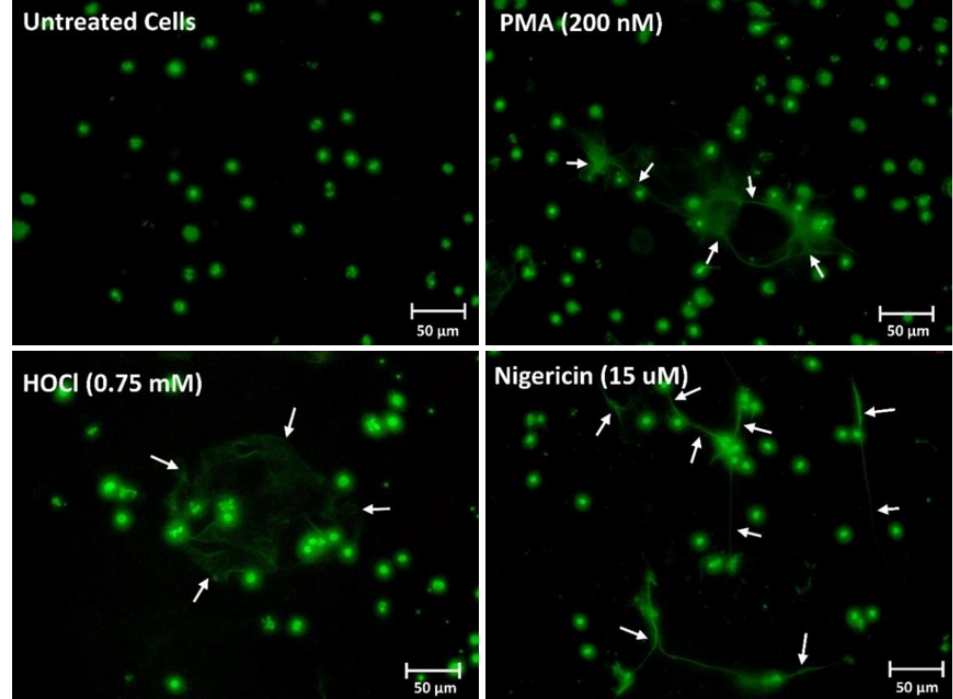
Figure 2. PMA, HOCl and nigericin induce NET release in differentiated PLB-985 cells. Differentiated PLB-985 cells (4 × 10 5 cells) were treated with PMA (200 nM), HOCl (0.75 mM) or nigericin (15 µ M) for 4 h at 37 ◦ C. After the treatment, the cells were fixed in 4% formaldehyde for 30 min and the DNA was stained with SYTOX green (2 µ M) for 10 min in the dark. The NETs are indicated by the white arrows. Images are representative of at least 3 independent